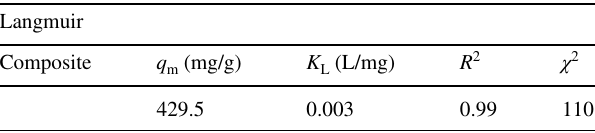
Table 5 Langmuir parameters for Rh6G adsorption by composite. T = 20 °C, pH = 6 Langmuir